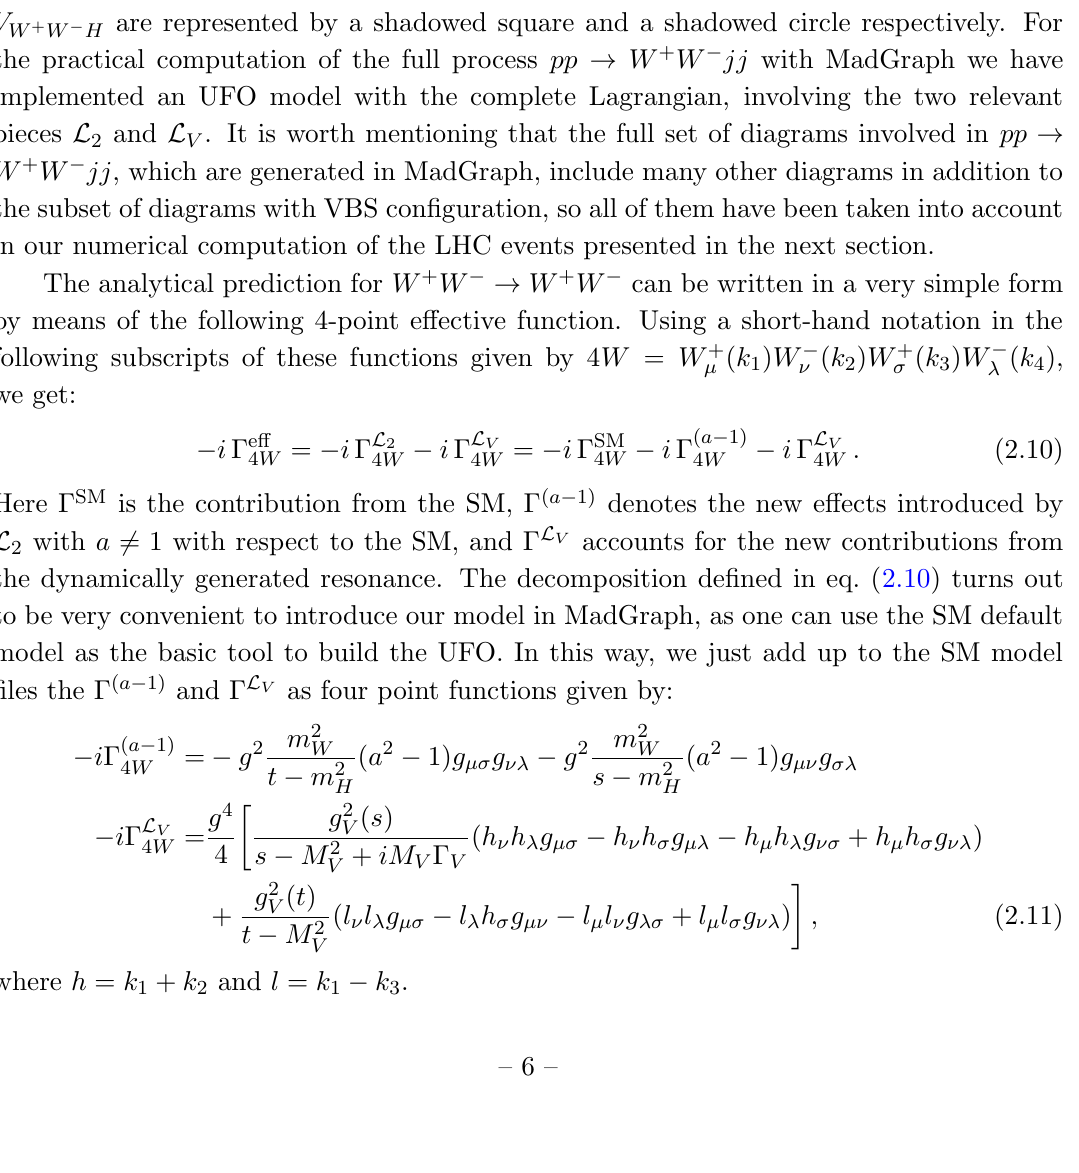
and a are given for each of them. In all these points 4 5